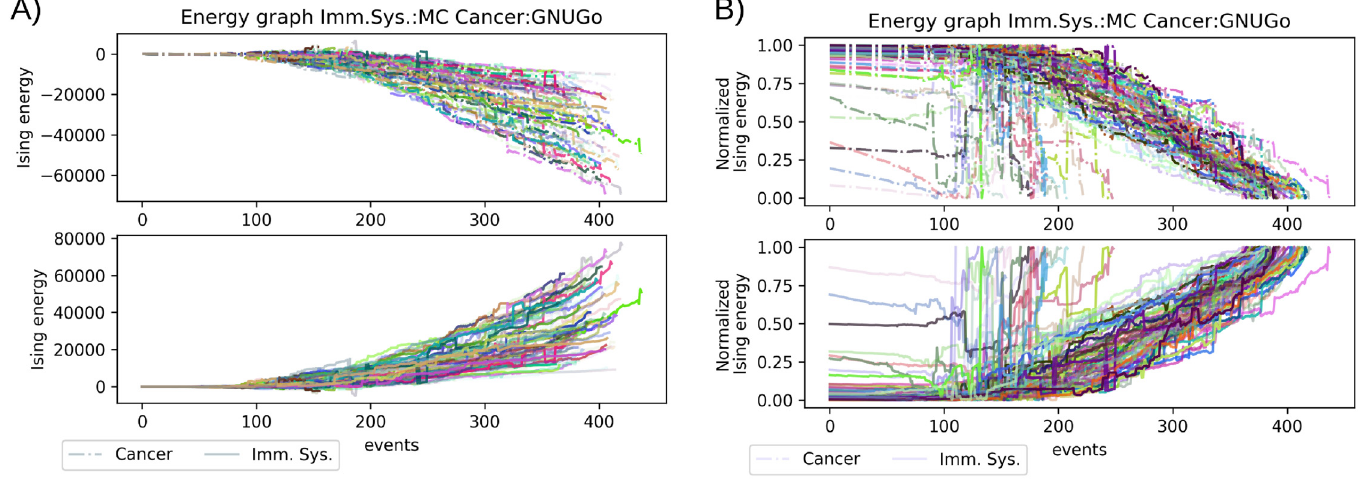
Fig 5. Comparison of the aggressive player vs aggressive player